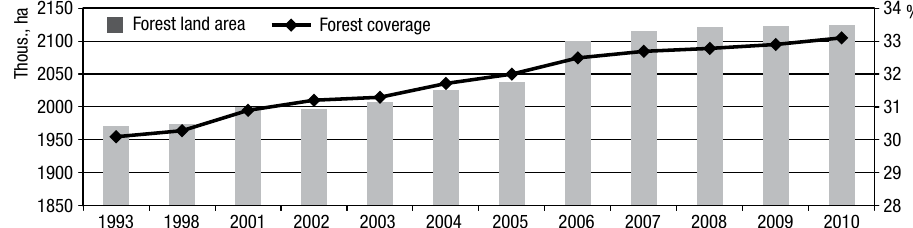
Fig. 7. Forest land area (ha) and forest coverage (percent) in Lithuania